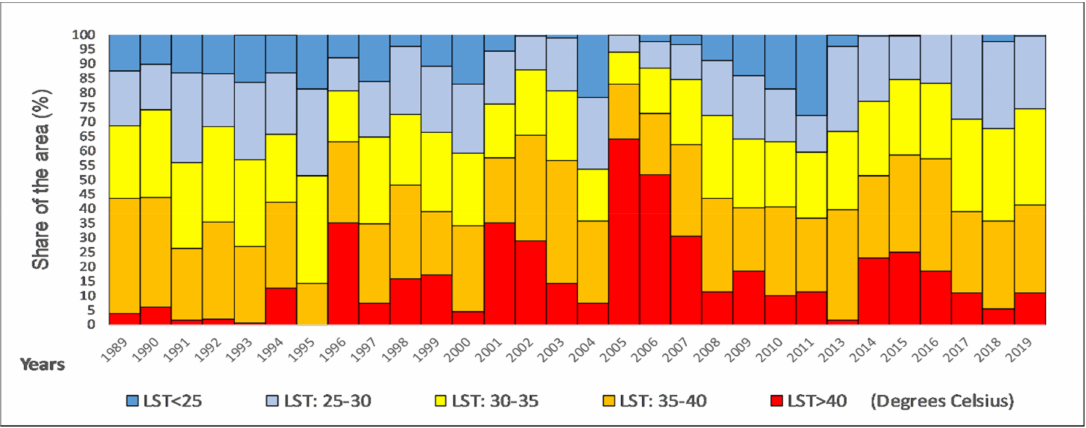
Figure 7. Coverage percentage by LST ranges from 1989 to